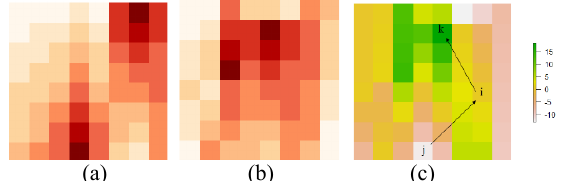
Figure 2. Flow extraction by density difference-based